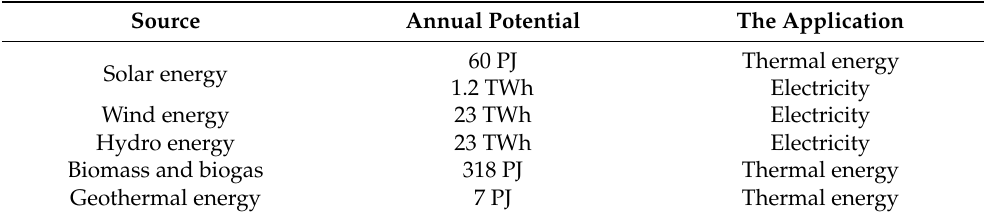
Table 1. The potential of renewable resources in